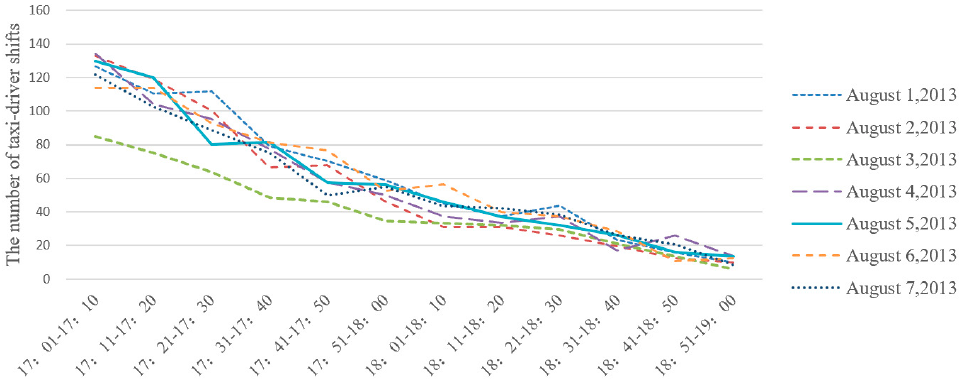
Figure 11. The number of taxi-driver shift events during the 5:00 p.m. to 7:00 p.m. period from August 1 to 7 in 2013.